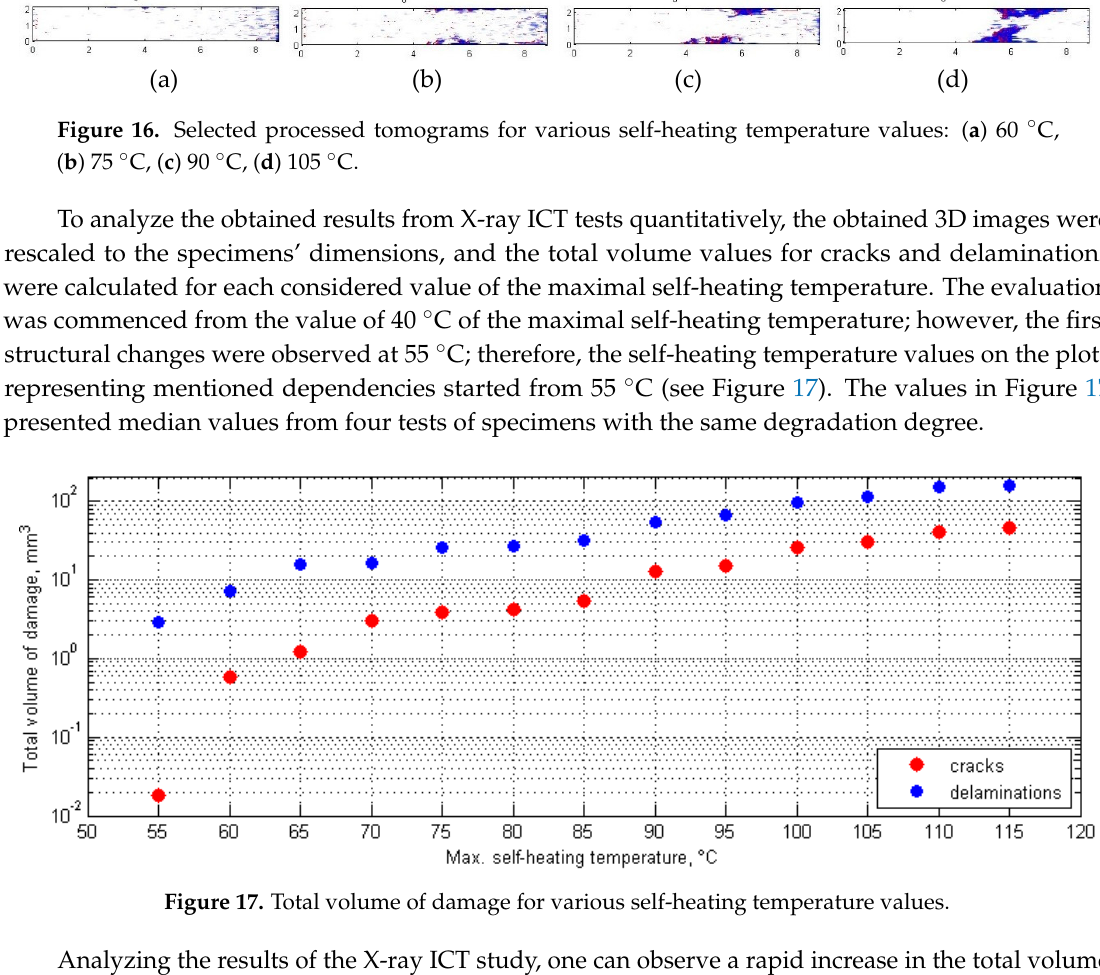
Figure 16. Selected processed tomograms for various self-heating temperature values: ( a ) 60 °C, ( b ) 75 °C, ( c ) 90 °C, ( d ) 105 °C.